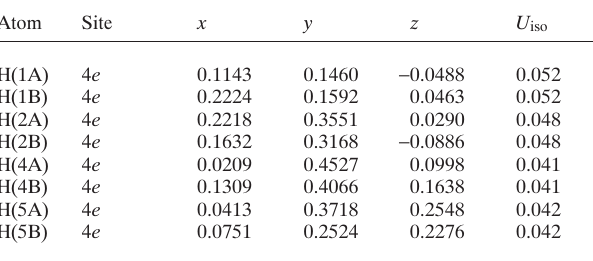
Table 2. Atomic coordinates and displacement parameters (in Å 2 )